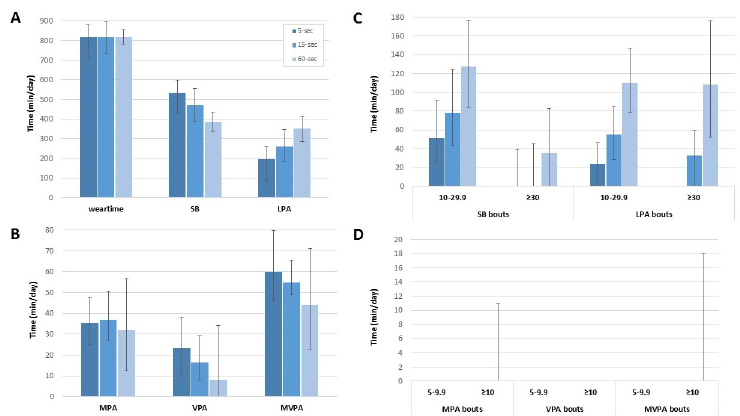
Fig 1. Estimates of total time and time accumulated in bouts of sedentary behaviour and physical activity. Total time estimates of A: Total wear time, sedentary behaviour (SB) and light physical activity (LPA), and B: Total moderate, vigorous and moderate-to-vigorous physical activity (MPA, VPA and MVPA); and total time estimates of time spent in C: Bouts of 10–29.9 and � 30 minutes of SB and LPA; and D: Bouts of 5–9.9 and � 10 minutes of MPA, VPA and MVPA, applying cut-points that are adjusted to match epoch lengths of 5, 15 and 60